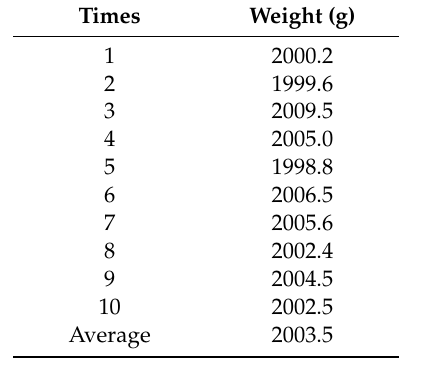
Figure 2. The sketch of the experimental setup for attenuation measurement. Table 2. The weight tests by an electronic scale.